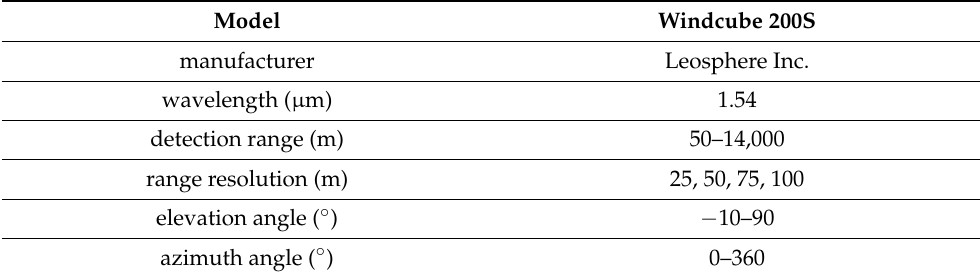
Table 1. The main specifications of the lidars in